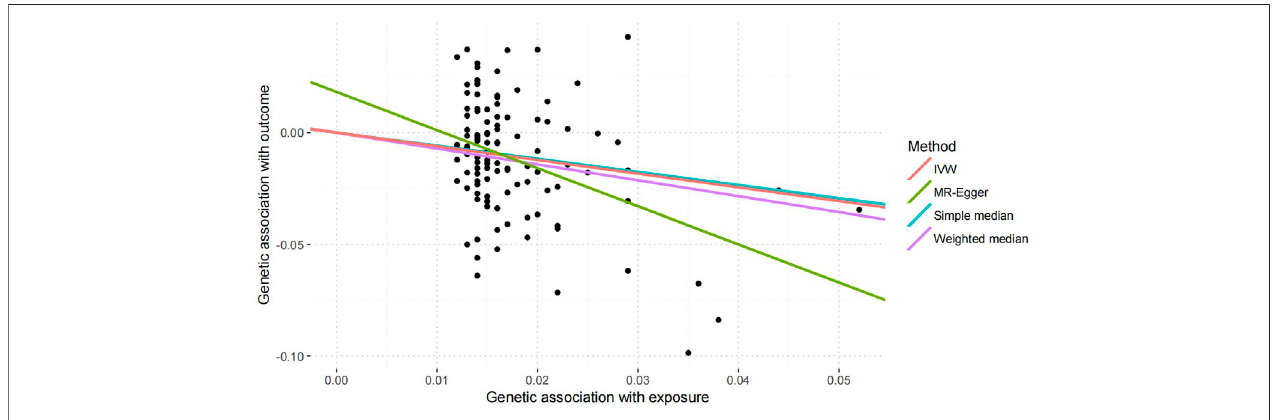
FIGURE1| Individualcausal estimatesfrom each ofthe111geneticvariants. Thisscatter plotshowsindividual causal estimatesfrom each of111geneticvariants associated with educational attainment on the x -axis and IS risk on the y -axis. The continuous line represents the causal estimate of educational attainment on IS risk.